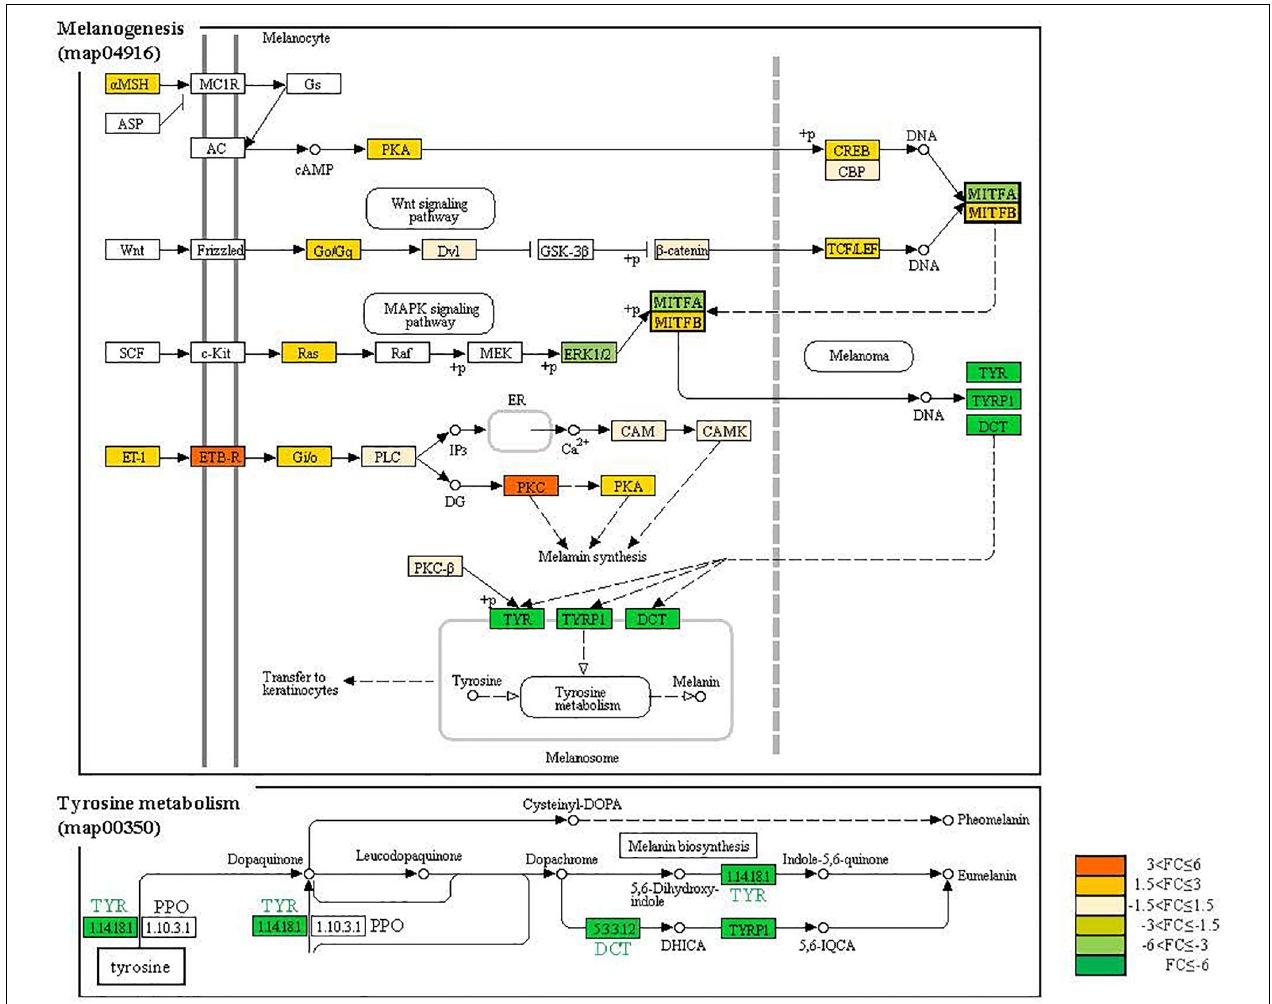
FIGURE 6 | The KEGG signaling map for melanogenesis and tyrosinase metabolism. The genes displayed with different colors according to FC value.